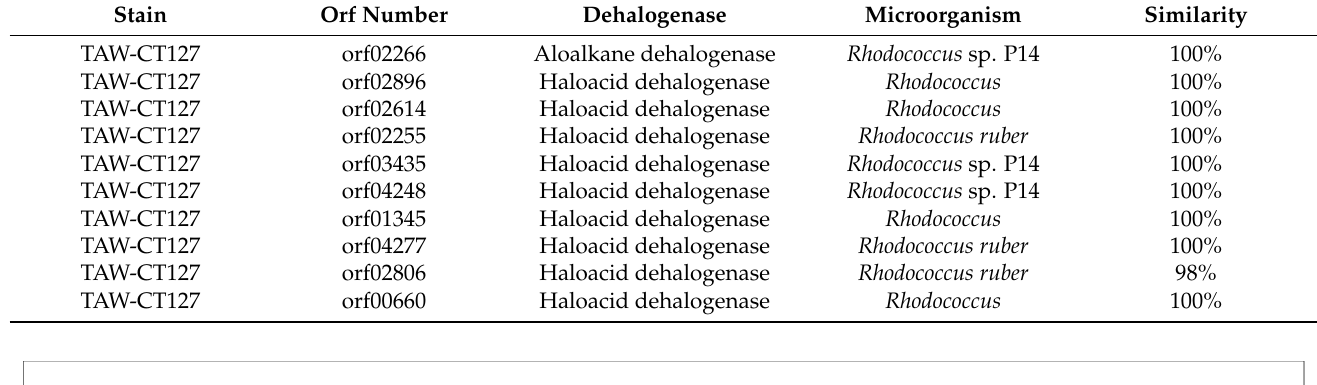
Table 3. Dehalogenases in the genome of strain TAW-CT127.